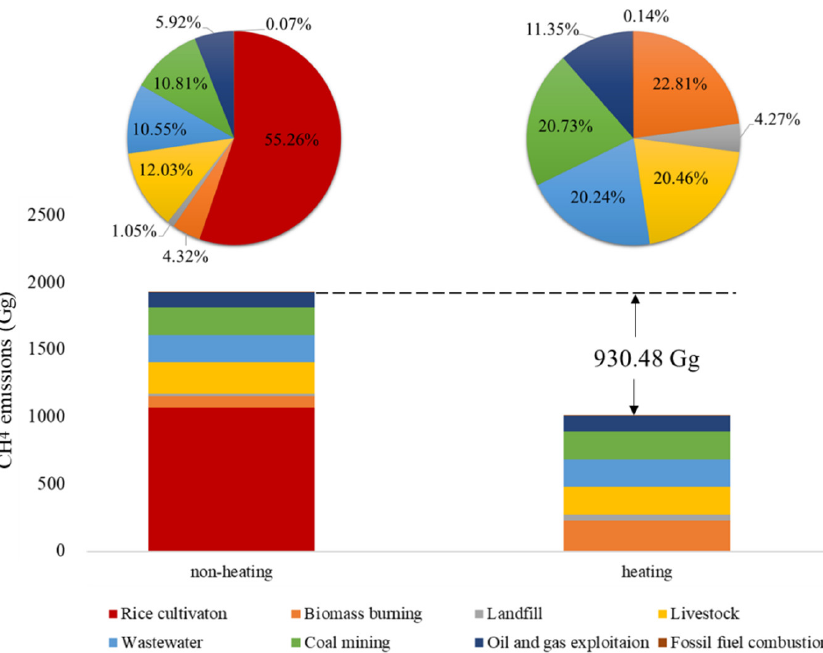
Figure 2. CH 4 emissions during the heating and non-heating periods in 2020.